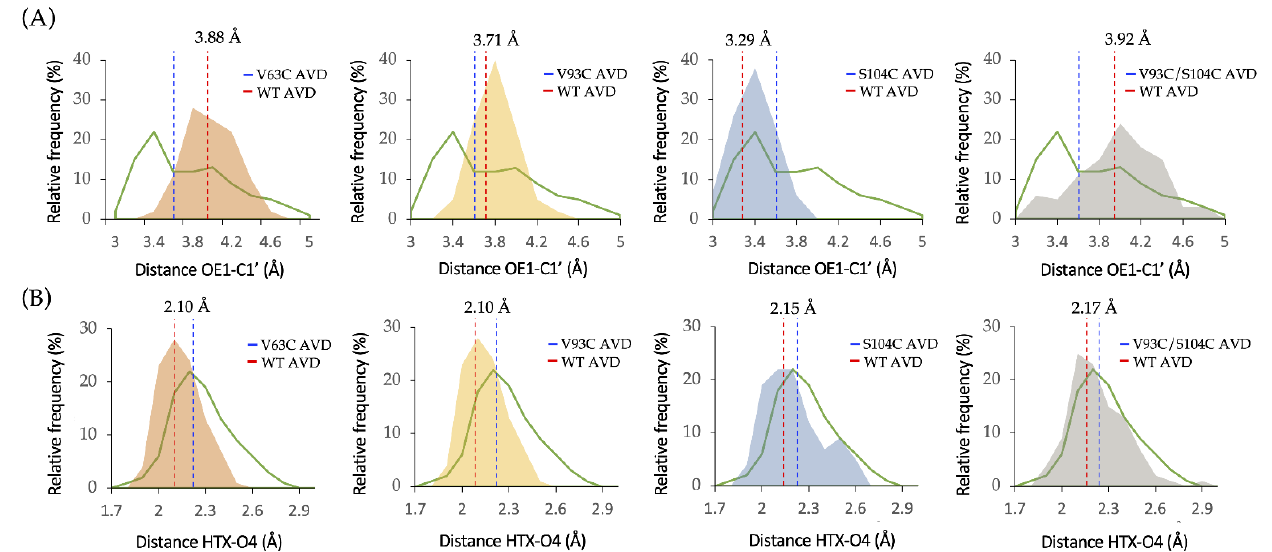
Figure 3. Overlap of distance distributions obtained in MD simulations of the different NDT-dUrd complexes. ( A ) d1 distance distributions for wild-type Ld NDT and mutants. ( B ) d2 distance distributions for wild-type Ld NDT and mutants. AVD: average distance; WT: Ld NDT; V63C: Ld NDT V63C ; V93C: Ld NDT V93C ; S104C: Ld NDT S104C ; V93C/S104C: Ld NDT V93C/S104C .